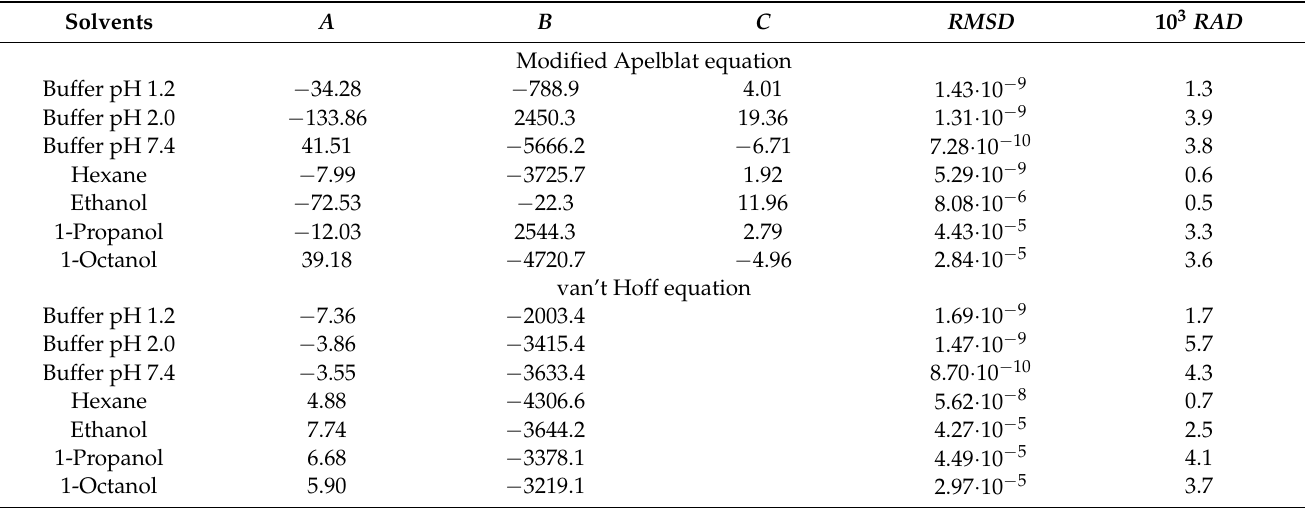
Table 5. Parameters of modified Apelblat and van’t Hoff equations for of IVZ in the selected solvents.